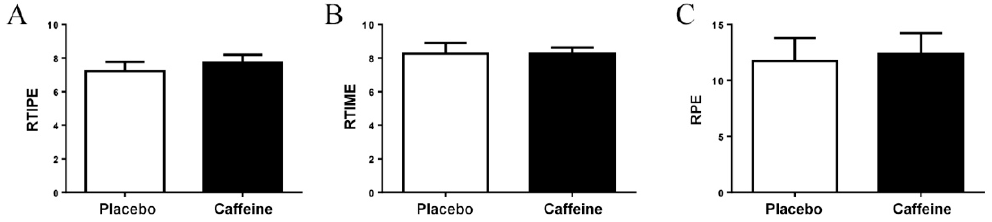
Figure 3. ( A ) Readiness to invest in physical effort; ( B ) Readiness to invest in mental effort; ( C ) Rating of perceived exertion.